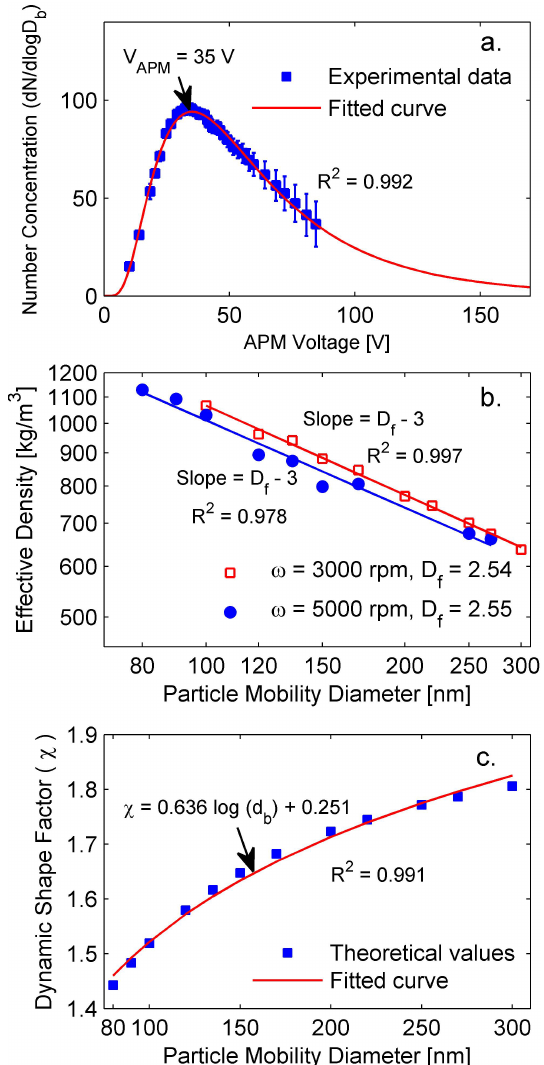
Figure 3. (a) Average number concentration of 100 nm (mobility size) pure silica particles downstream the APM and at a rotation speed of the APM of 3000rpm. The number concentrations were averaged over 1 min for each APM voltage, and the error bars rep- resent the standard deviation of about 60 measurements recorded under the same conditions. (b) Effective density of silica particles for different mobility diameters and two different rotation speeds of the APM (3000 and 5000rpm). The fitted fractal dimensions are 2.54 and 2.55, respectively. (c) Mass-based shape factor versus elec- trical mobility diameter for silica particles.